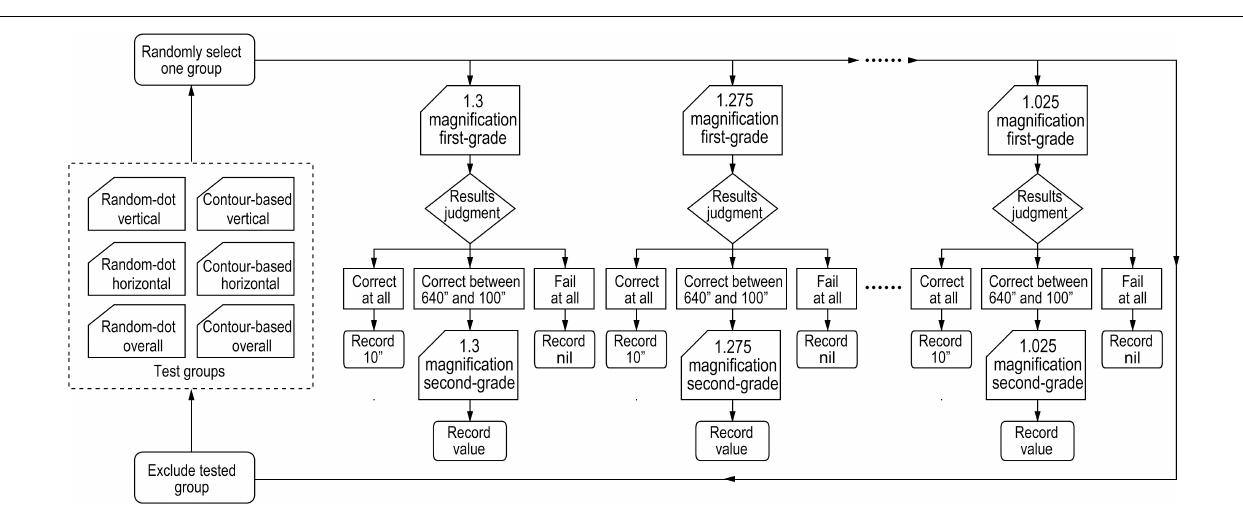
FIGURE 5 | Flowchart of test procedure of determining the threshold for stereopsis under induced aniseikonia conditions. Test groups included three random-dot-based patterns (overall, horizontal, or vertical aniseikonia) and three contour-based patterns (overall, horizontal, or vertical aniseikonia). One group was selected randomly to test a participant. Two-step choices were conducted to measure the stereopsis threshold with a magnification of 1.3, and then 1.275, and so on, until it reached 1.025. Randomly, another group was chosen to do the examination again, and so on, until finishing all the six groups’